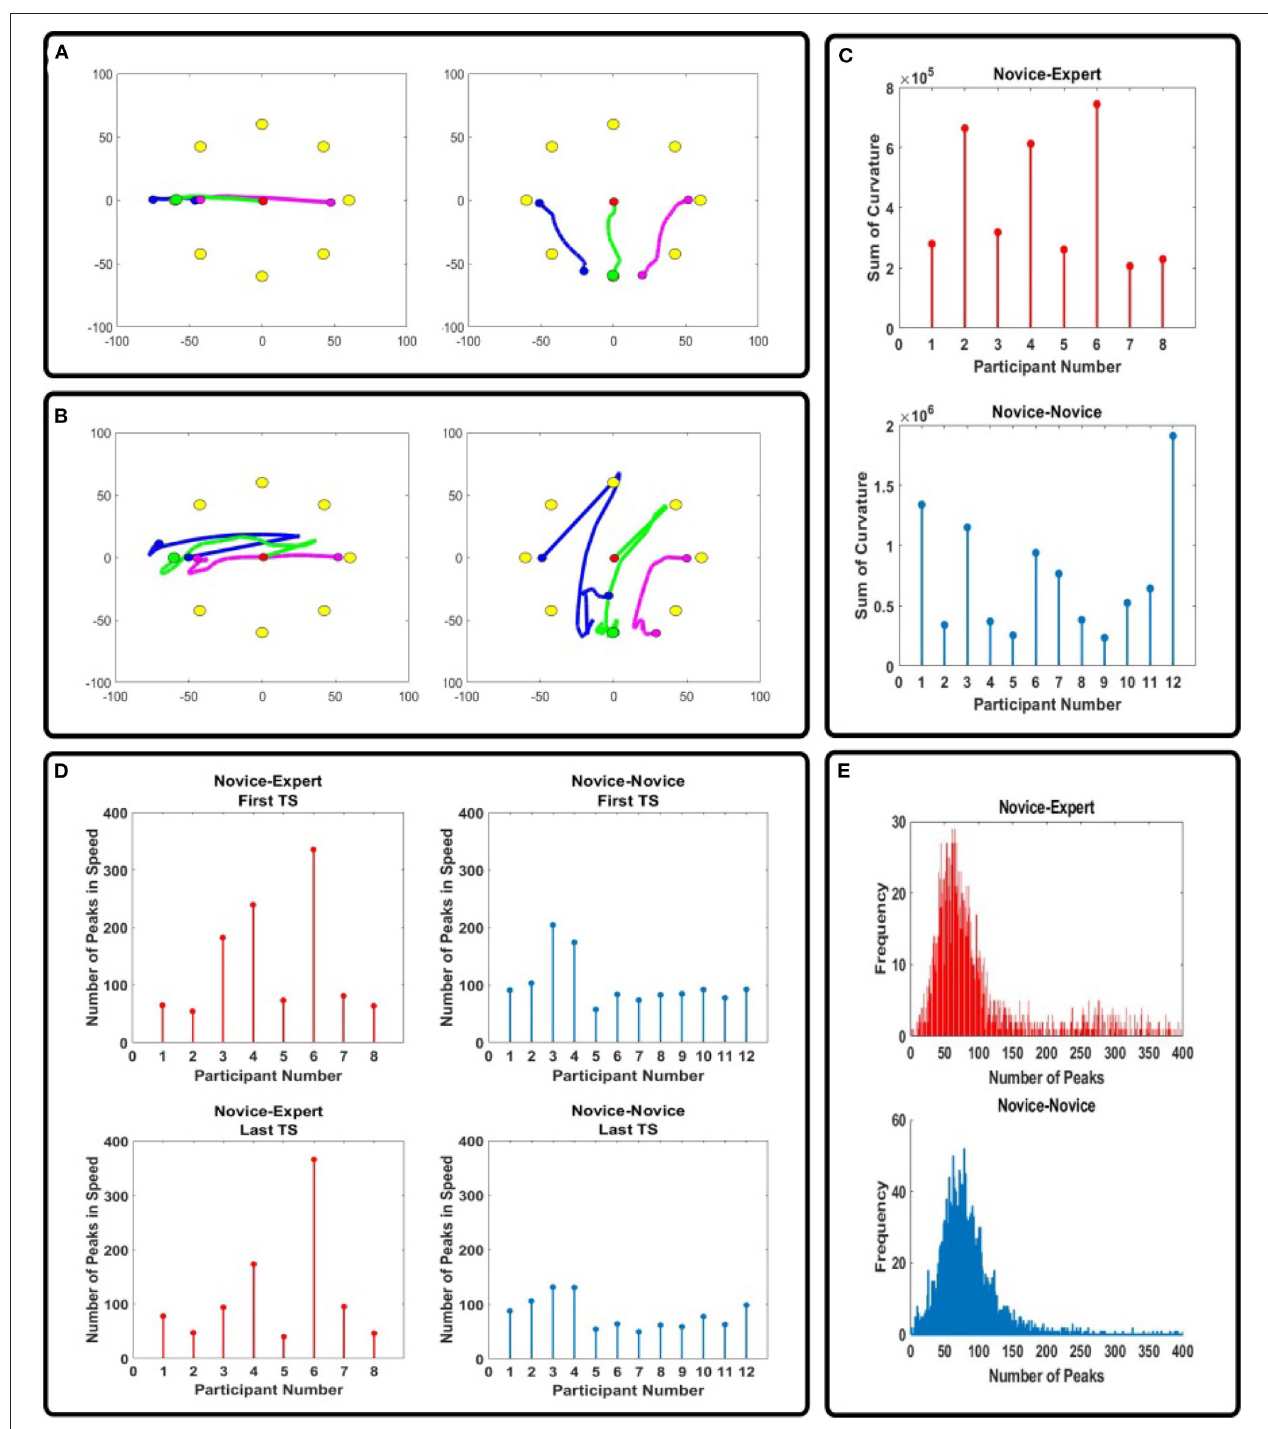
FIGURE 5 | (A) Samples of the trajectories generated by N-E group in the Learning phase. (B) Samples of the trajectories generated by the N-N group in Learning phase. Green circle shows the final position of the virtual mass. After completing the task, the participants were asked to bring their cursors (blue and purple circles) to the starting point which was set as [ − 50,0] and [50,0]. The blue and purple line indicate the trajectories generated by the participants, and also the trajectories of the virtual mass is shown with the green line. (C) Sum of the curvature of the cursor trajectory during the Learning phase for each participant. (D) Change of the number of peaks in velocity between the first TS and last TS of the Learning phase. (E) Distribution of the number of peaks across all trials in the Learning phase.